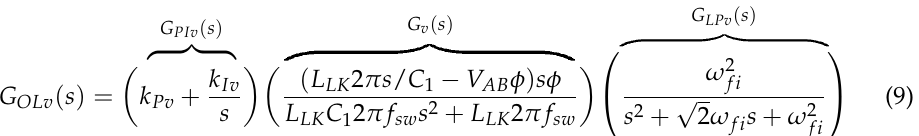
Figure 14. Block scheme of the control loop used to achieve the control tuning of the DAB converter.